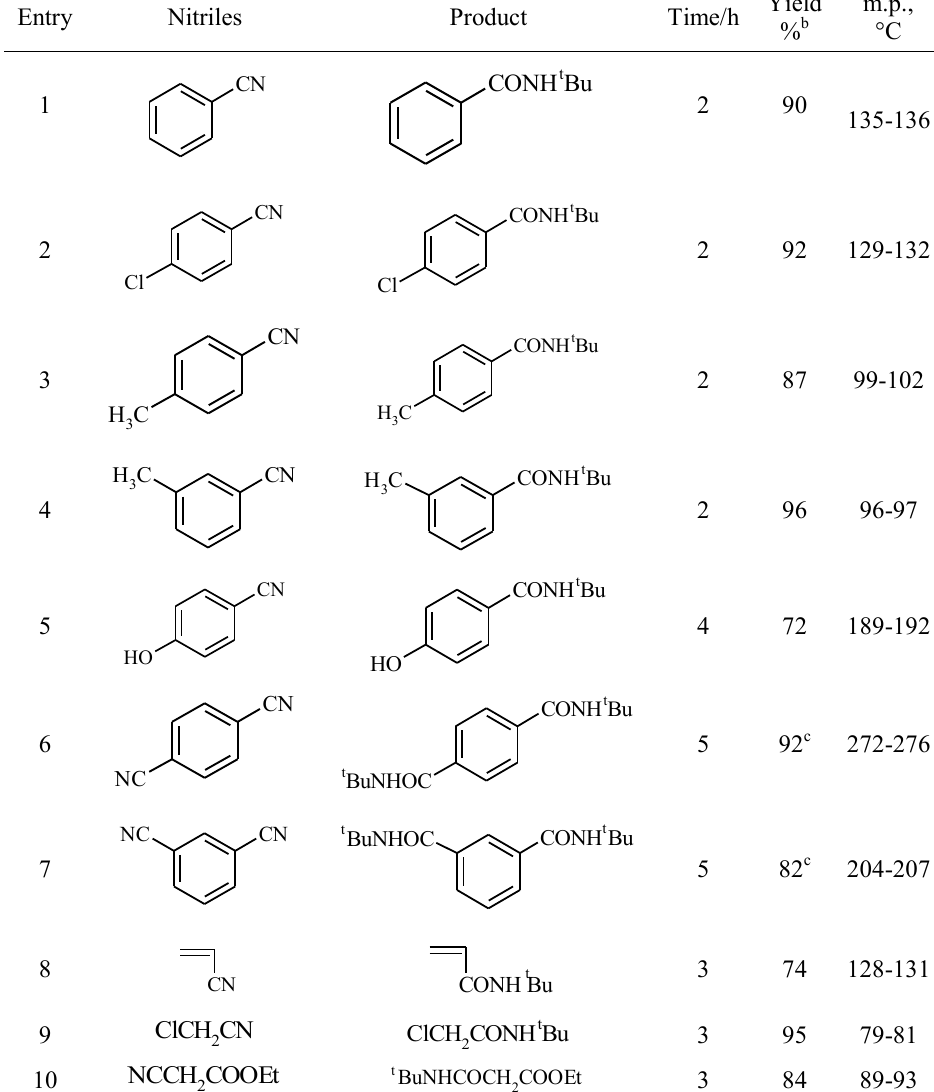
Table 1 . Amidation of tert -butyl acetate with nitriles using of the PVPP-BF 3a . Entry